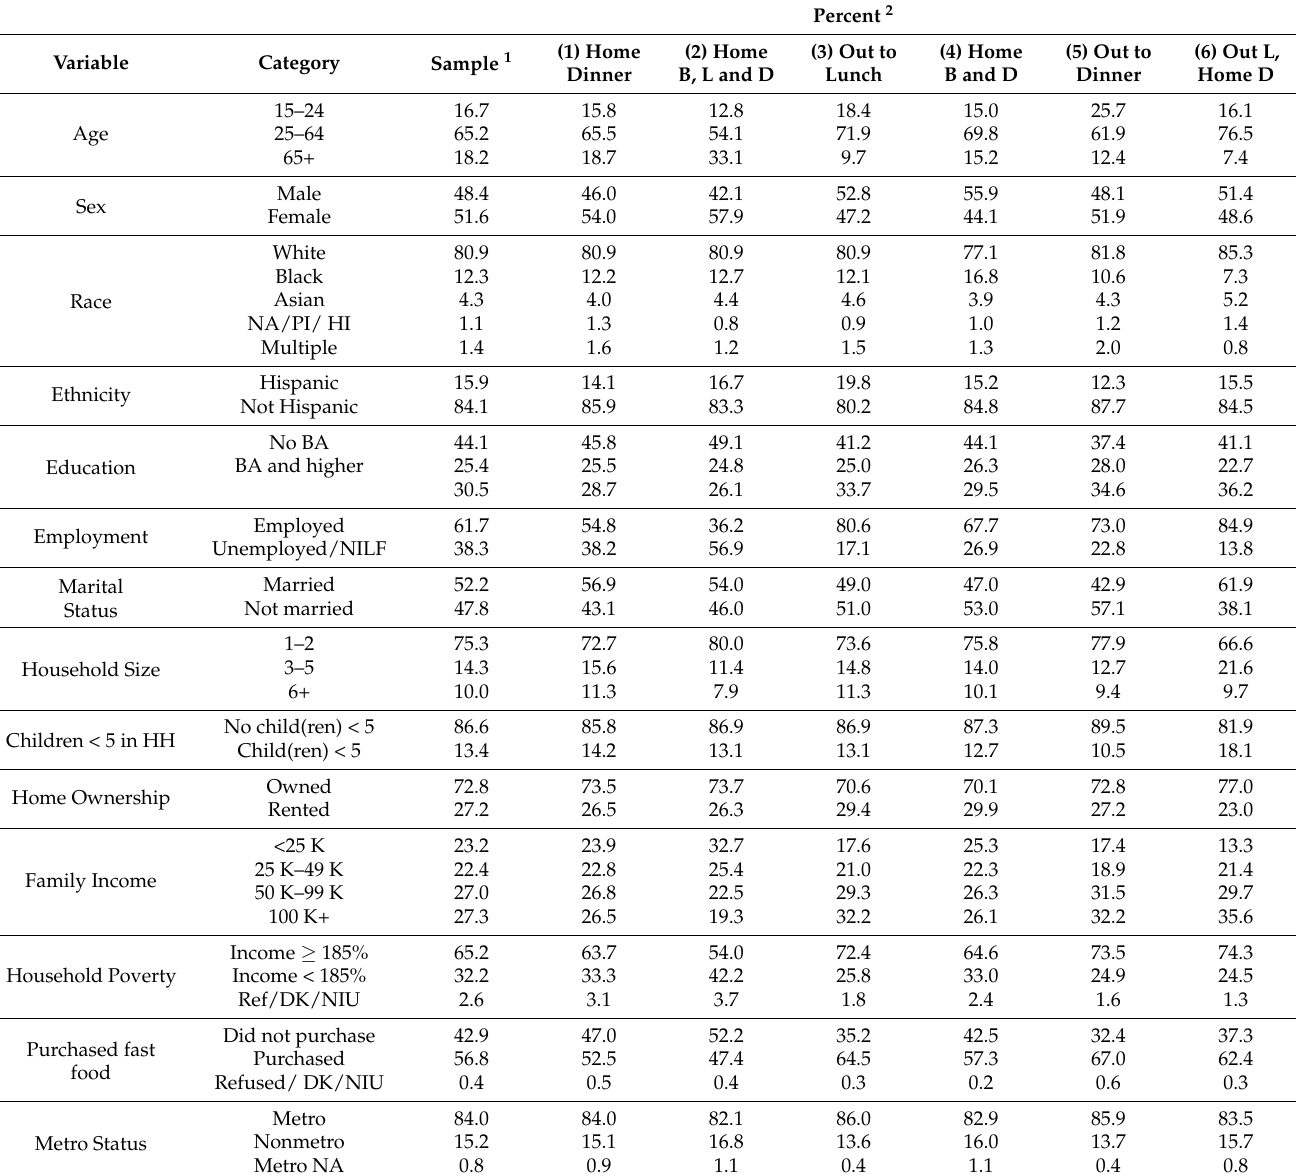
Table 3. Descriptive Statistics for Sample and by Cluster ( n = 15,872; survey weights